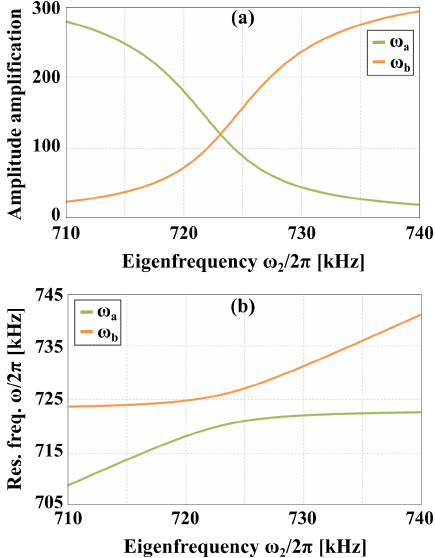
Figure 9. (a) Amplitude amplification factor for both resonance peaks and (b) resonance frequencies of the coupled system with varying eigenfrequency ω 2 = 2 πf 2 of the nanocantilever.